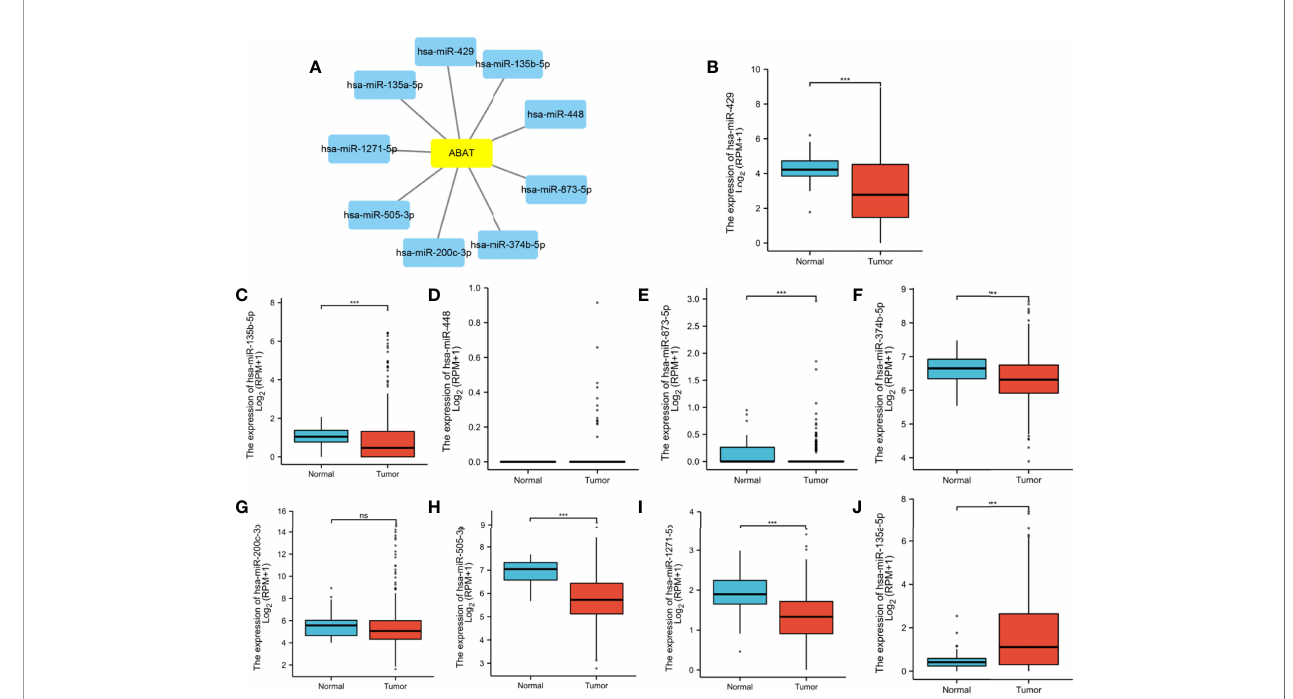
FIGURE 8 | (A) Establishment of miRNA-ABAT regulatory network with Cytoscape software and (B – J) the expression of candidate upstream miRNAs of ABAT in HCC tissues and normal tissues. NS, P = 0.05 or higher; ***P < 0.001.